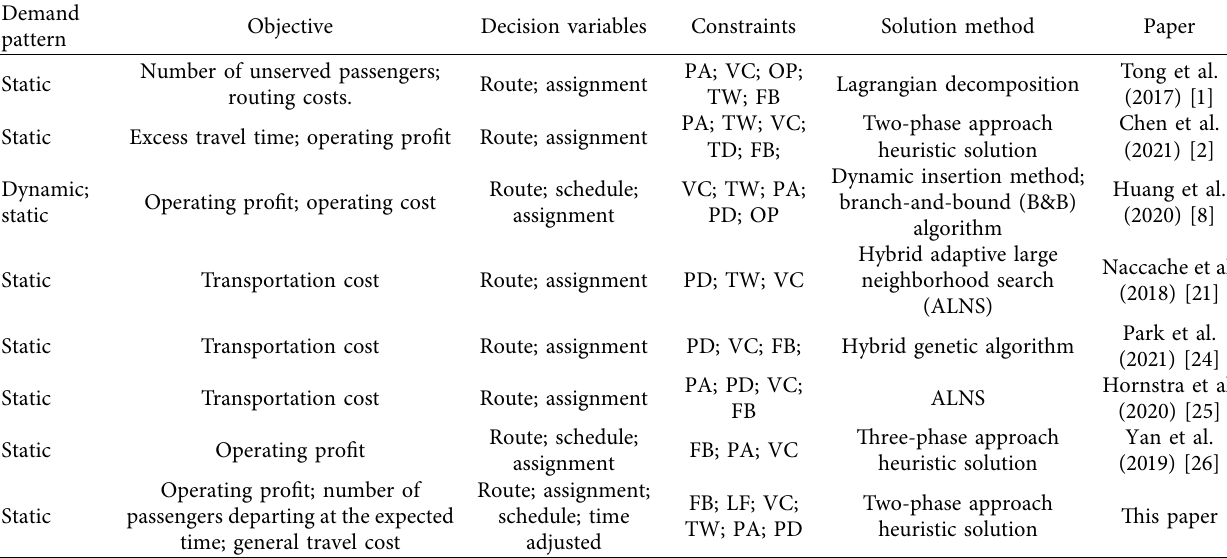
Figure 1: The framework of DRT with the slack departure Table 1: The latest researches on the DRT system.